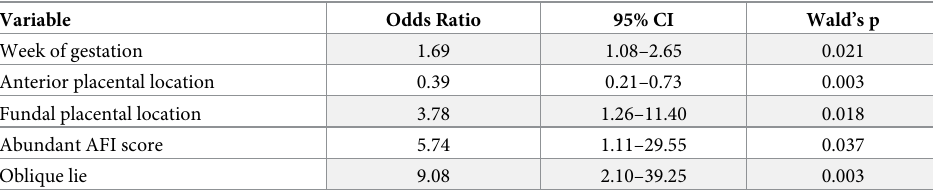
Table 2. Logistic